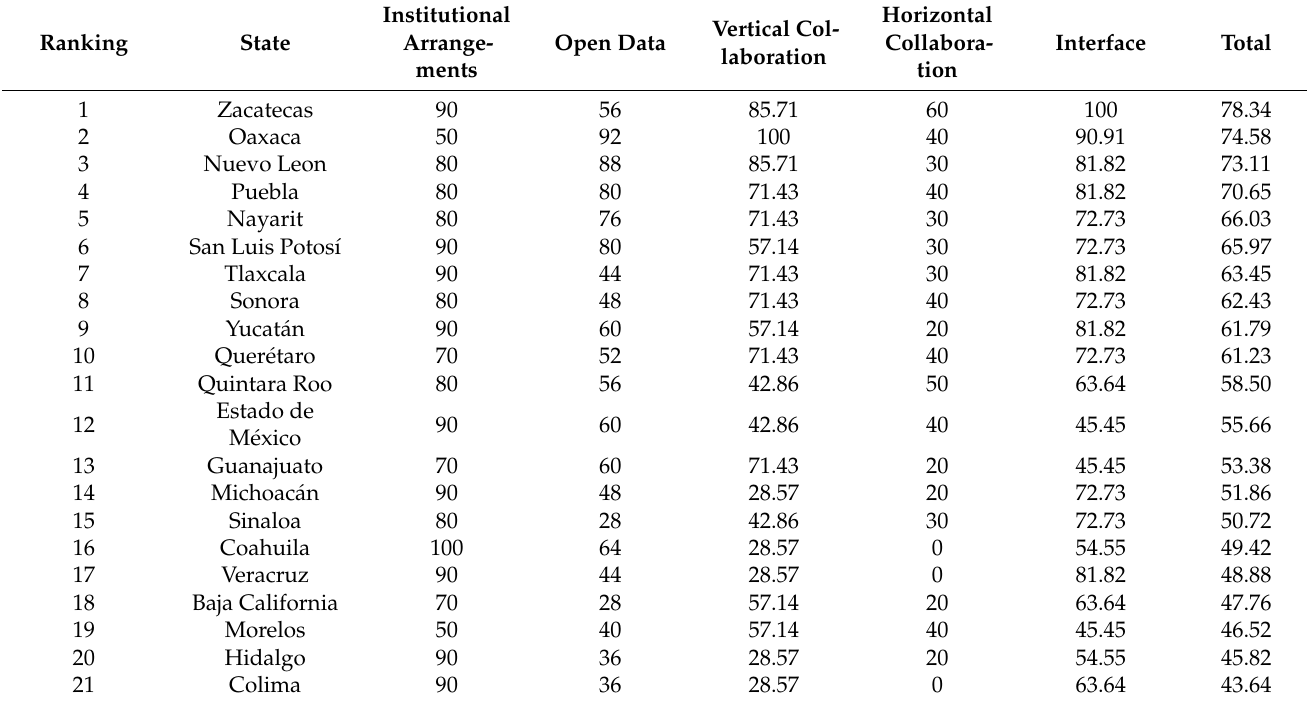
Table A1. Ranking of the transparency portal of the states of